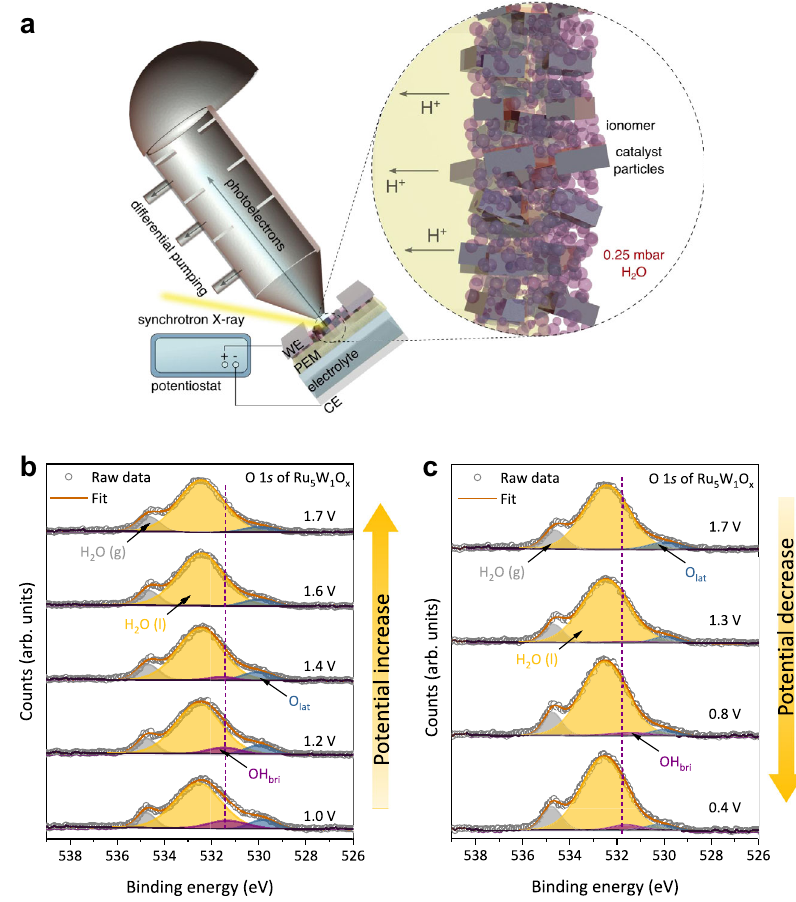
Fig. 4 | In situ spectroscopic investigation of OER process. a A schematic of the in situ electrochemical measurements. The zoom area illustrates the major com- ponents at the measured electrochemical interface. b, c In situ electrochemical O 1 s XPS spectra of Ru 5 W 1 O x . As the potential increased, the OH bri peak decreased